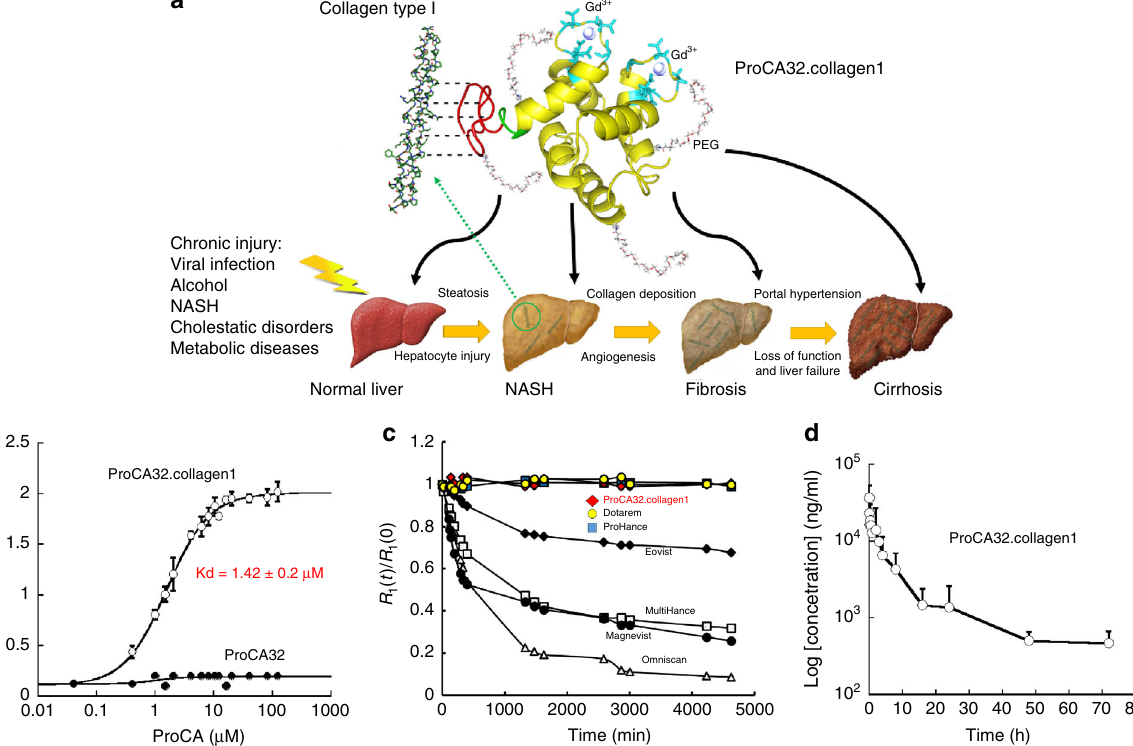
Fig. 1 Development of ProCA32.collagen1 and its biophysical characteristics. a The model structure and development of ProCA32.collagen1 by engineering collagen type I targeting moiety (GGGKKWHCYTYFPHHYCVYG, red) at C-terminal of ProCA32 using a fl exible hinge (green) and PEGylation. b Measurement of the dissociation constant of ProCA32.collagen1 to collagen type I using indirect ELISA assay. No collagen I binding was observed for ProCA32 (PEGylated, nontargeted agent). c The relaxation rates change of clinical contrast agents (black diamond Eovist; black circle Magnevist; white square MultiHance; white triangle Omniscan; blue square ProHance; yellow circle Dotarem) and red lozenge ProCA32.collagen1 in the presence of ZnCl 2 at different time points up to 4 days. d Pharmacokinetic of ProCA32.collagen1. Gd 3 + concentration in serum collected after injection of ProCA32.collagen1 was determined by ICP-OES. Error bars indicate standard deviations of six separate measurements in n = 6, biologically independent animals